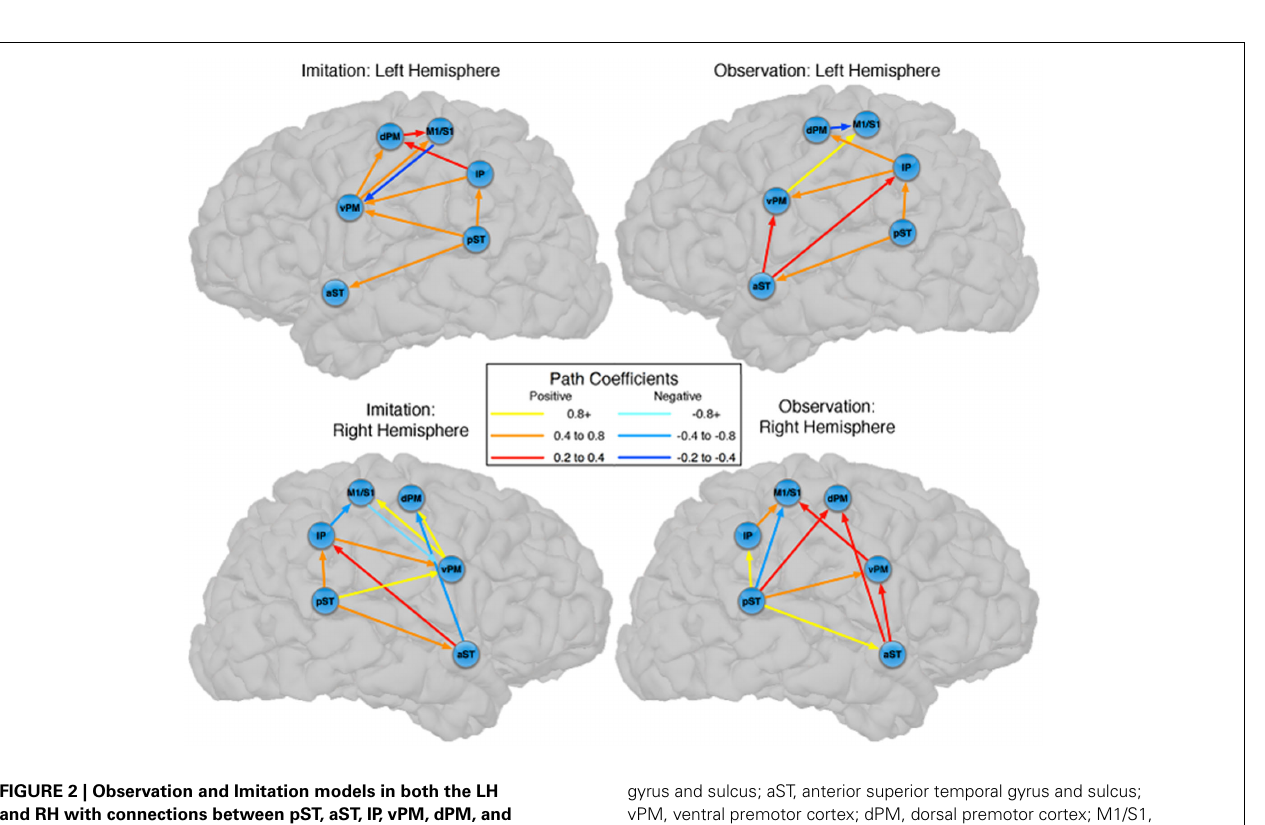
gyrus and sulcus; aST, anterior superior temporal gyrus and sulcus; vPM, ventral premotor cortex; dPM, dorsal premotor cortex; M1/S1, primary motor/somatosensory cortex. Anatomical definitions of the regions are provided in Table 1